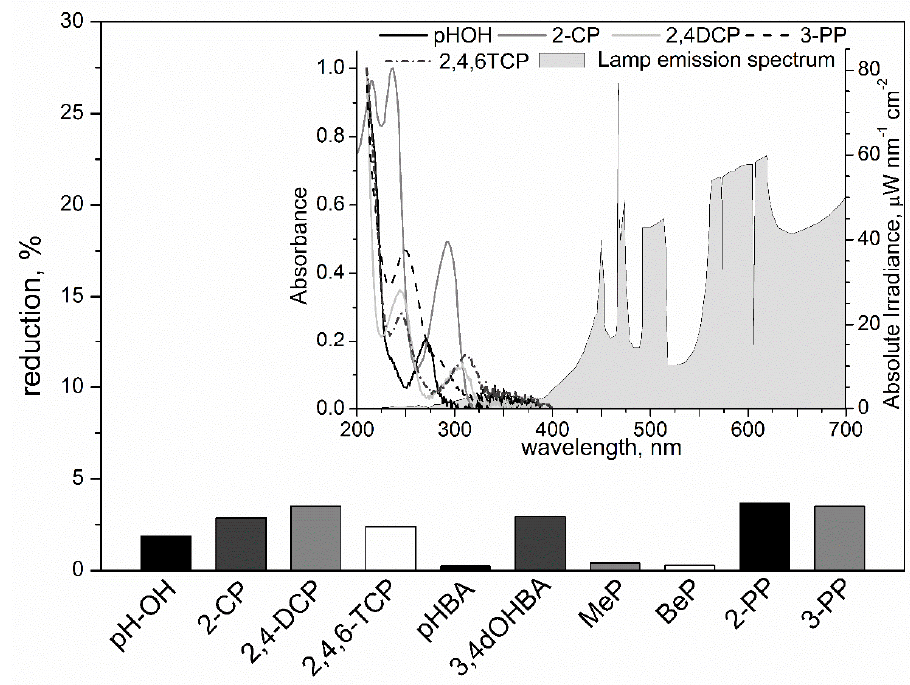
Figure 4. Relative reduction of compound concentration in the solution after 180 min of photolysis. Absorption spectra of compounds and lamp emission spectrum (insert).